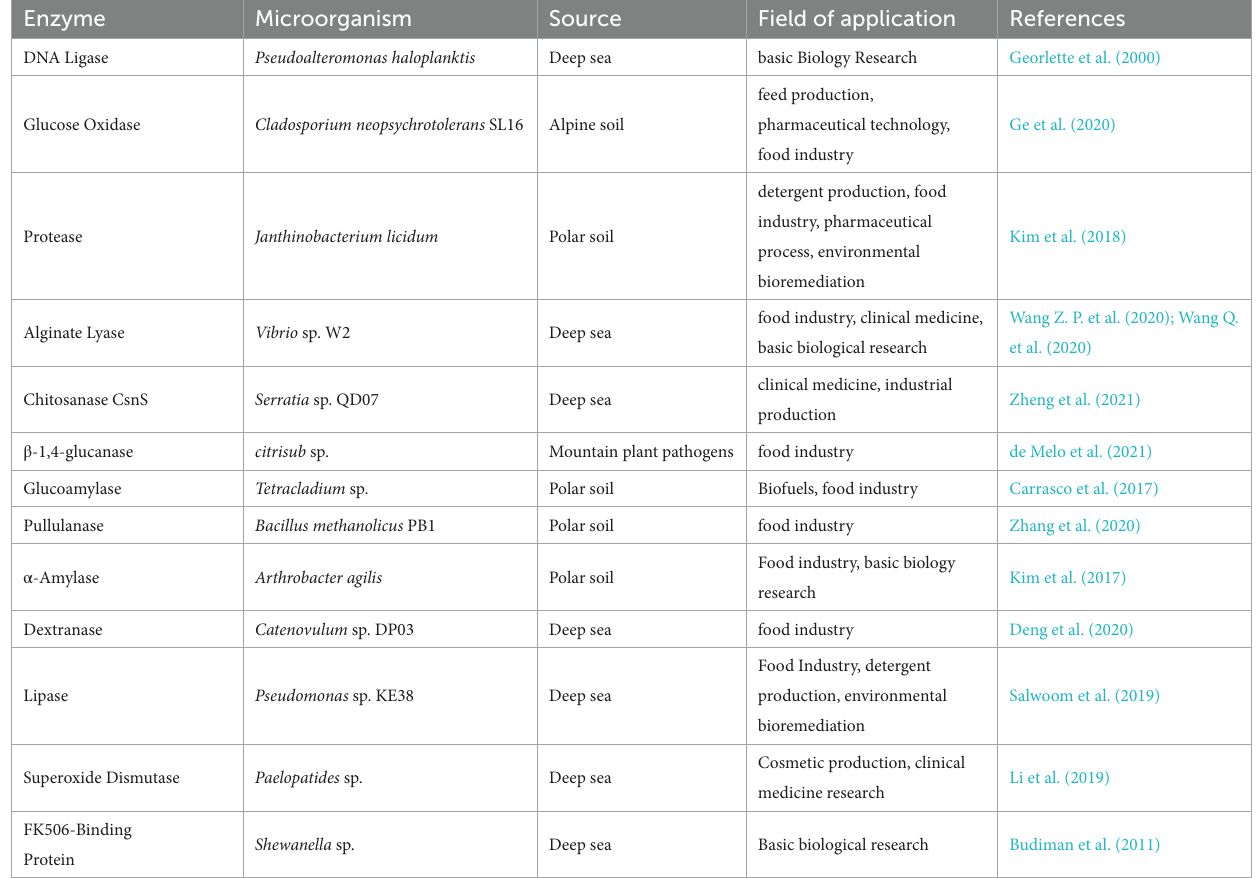
TABLE 4 Cold-adapted enzymes from various microorganisms and associated